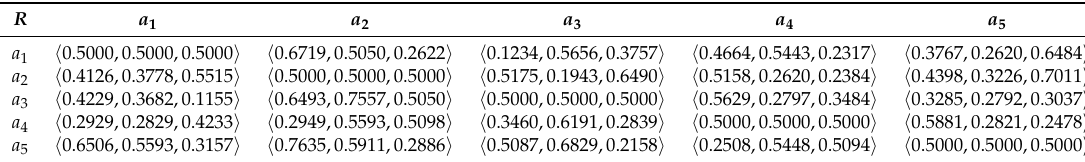
Table 8. The collective SVNPR of all the above individual SVNPRs.